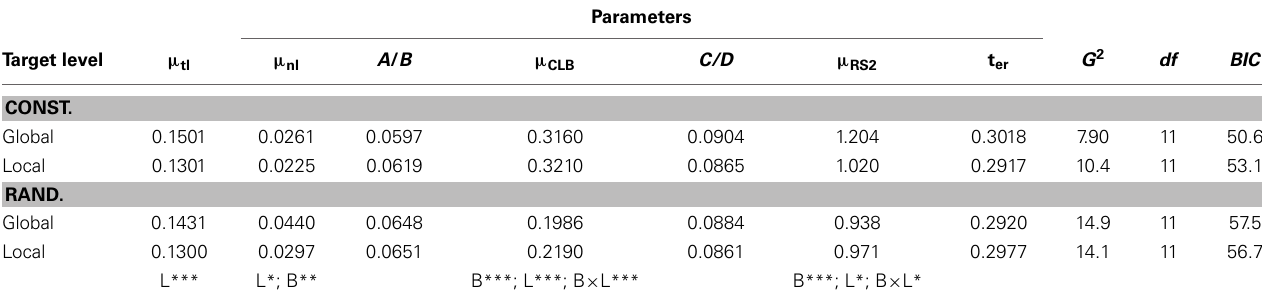
Table 1 | Parameter estimates obtained by fitting the DSTP model to the distributional data of the four conditions in the experiment.